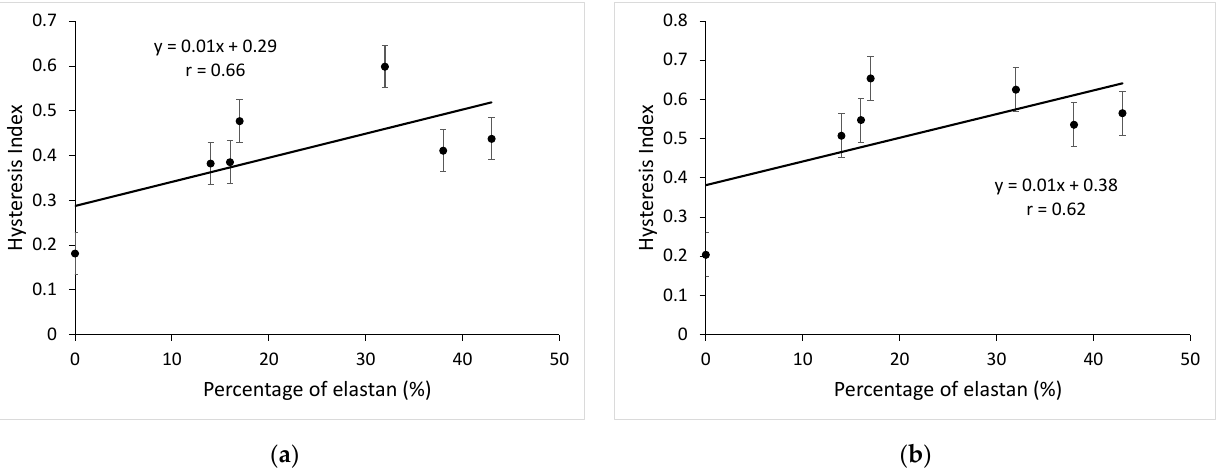
y = 0.01x + 0.29 r = 0.66 Figure 10. Relation between the percentage of elastane in the knitted fabric and the hysteresis index: ( a ) in the wale direction; ( b ) in the course direction.